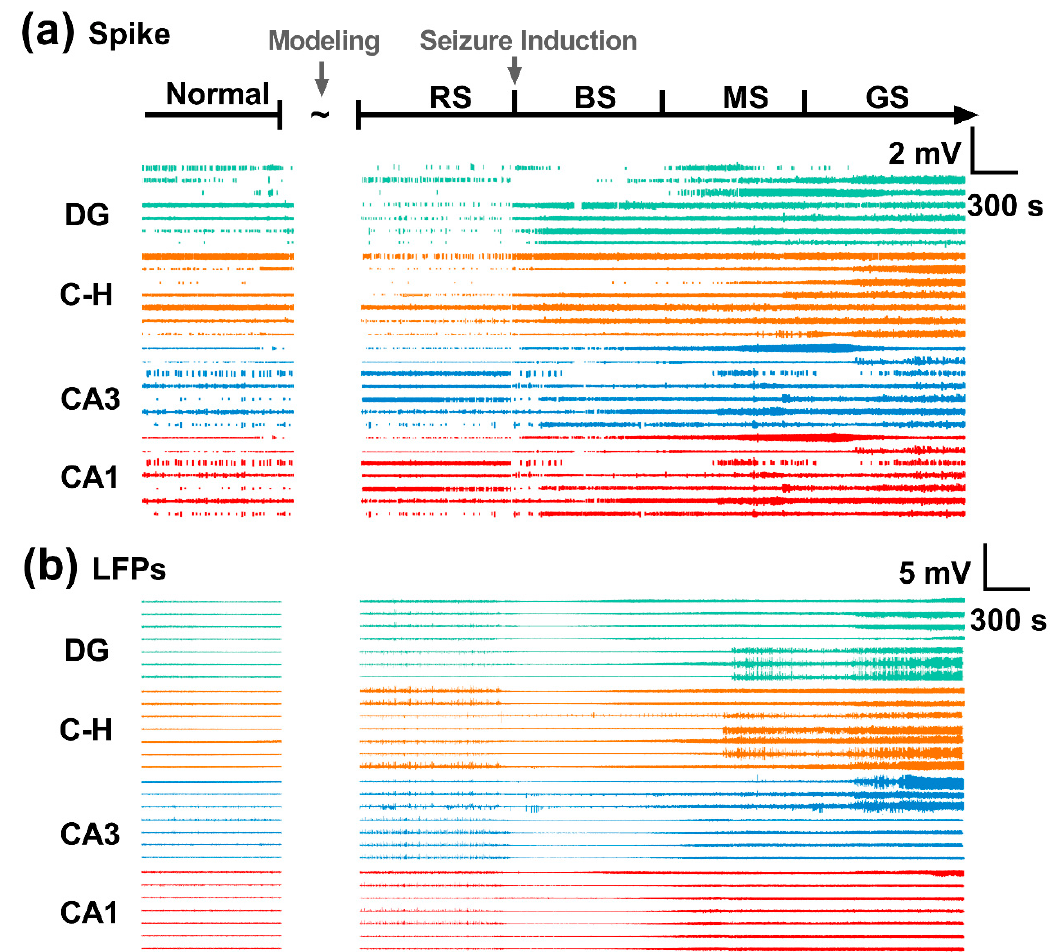
Figure 5. In vivo recording of neural electrophysiology. ( a ) Neural spikes and ( b ) local field potentials (LFPs) during the normal stage and the resting state (RS), beginning stage (BS), middle stage (MS), and grand mal stage (GS) of seizure. C-H: hilus.